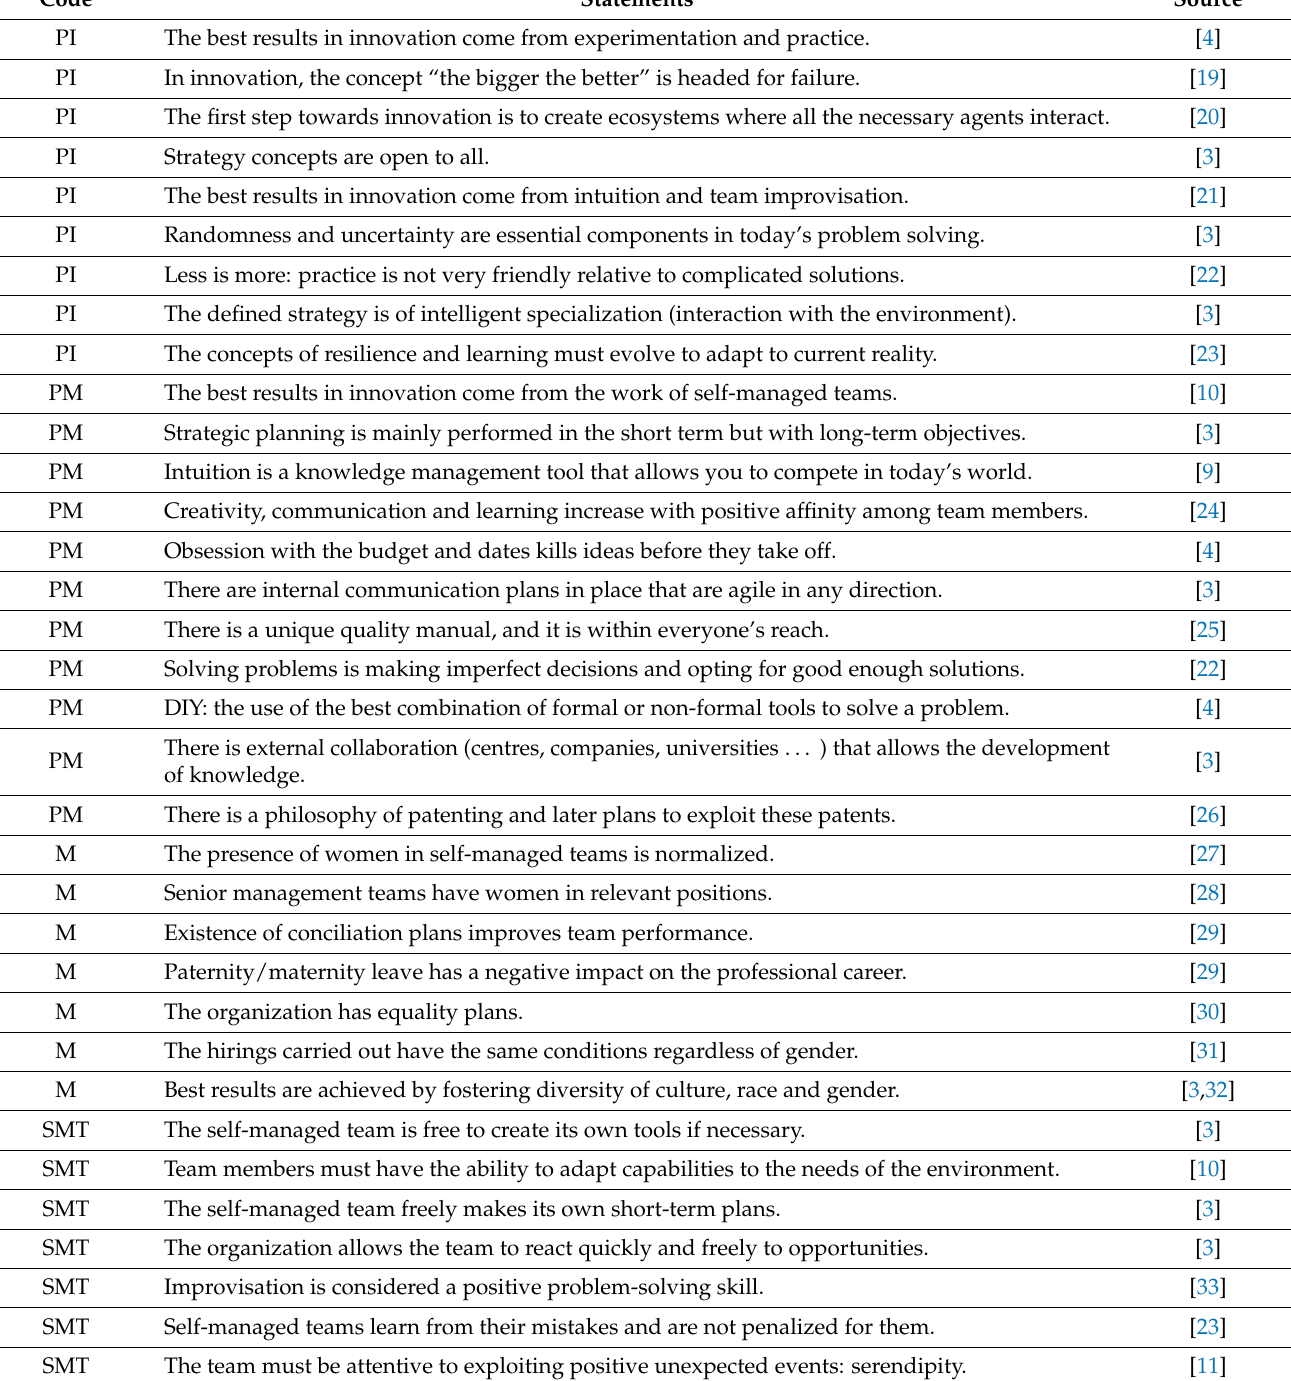
Table 1. The statements for the